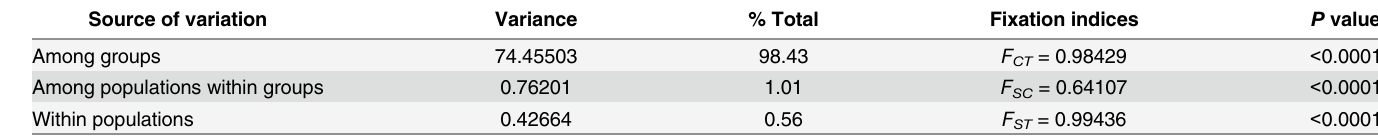
Table 1. Analysis of molecular variance (AMOVA) among ND2+tRNA sequences of O. schmackeri species complex.